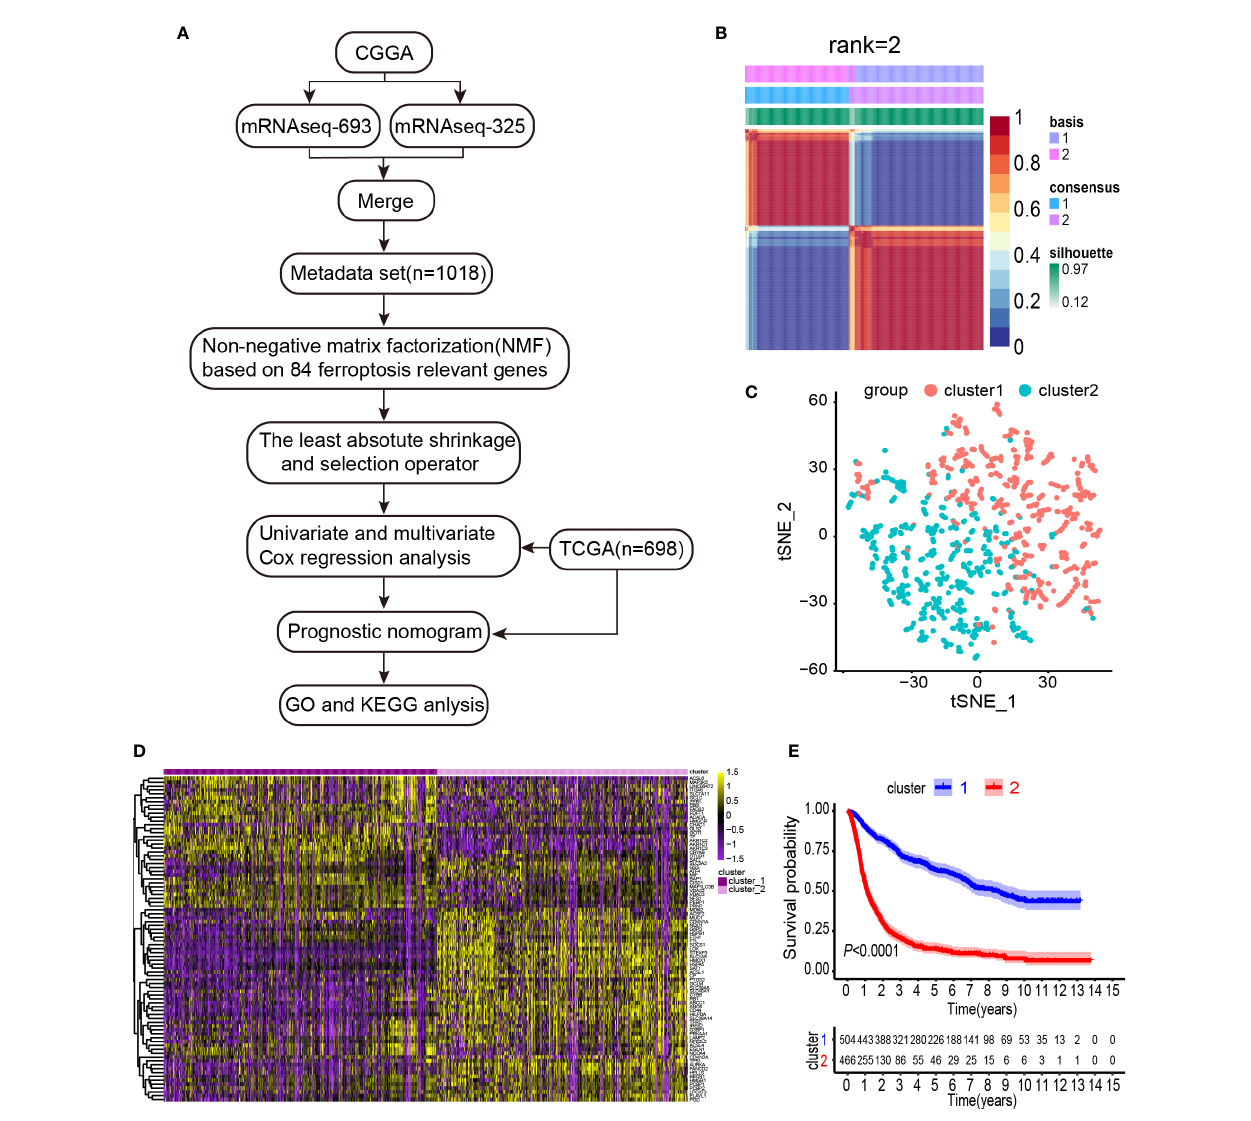
FIGURE 1 | Identi fi cation of gliomas subclasses using NMF consensus clustering in the ferroptosis set. (A) Flow chart of the study. (B) NMF clustering using 84 ferroptosis-related genes. Patients were divided into cluster 1 and cluster 2. (C) t-SNE analysis supported the strati fi cation into two gliomas subclasses. (D) Heat map of two clusters de fi ned by the ferroptosis-related genes expression. (E) Survival analysis of patients in Clusters 1 and 2 in CGGA